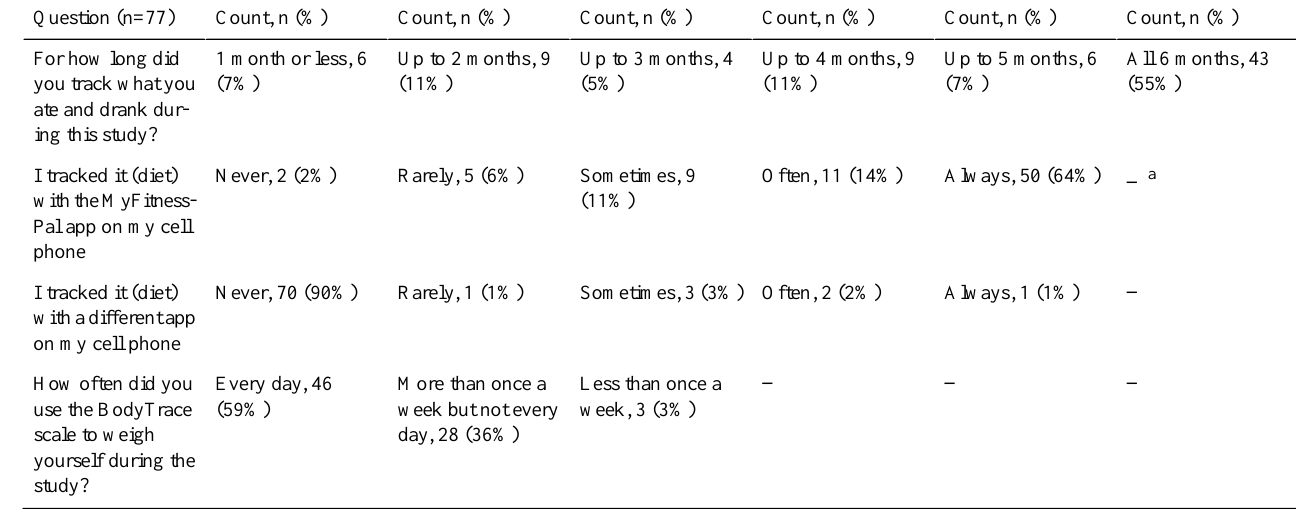
Table 3. Postintervention survey